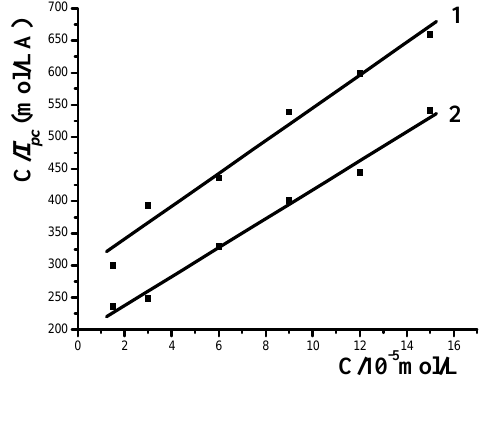
Figure 3. Plot of C / I vs. C at ssDNA/MAA/Au (1) and dsDNA/MAA/Au electrodes pc